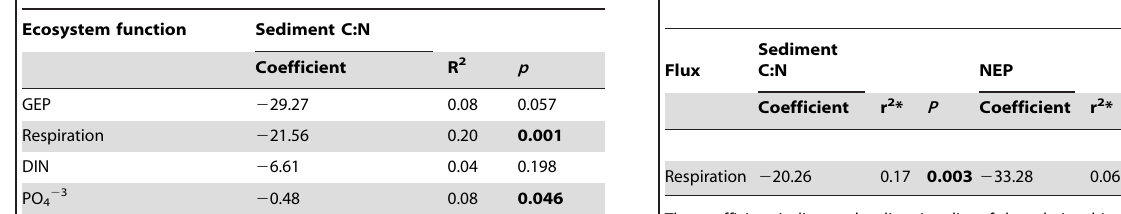
Table 4. Ecosystem respiration as a function of sediment organic matter quality and net ecosystem production (i.e. autochthonous organic